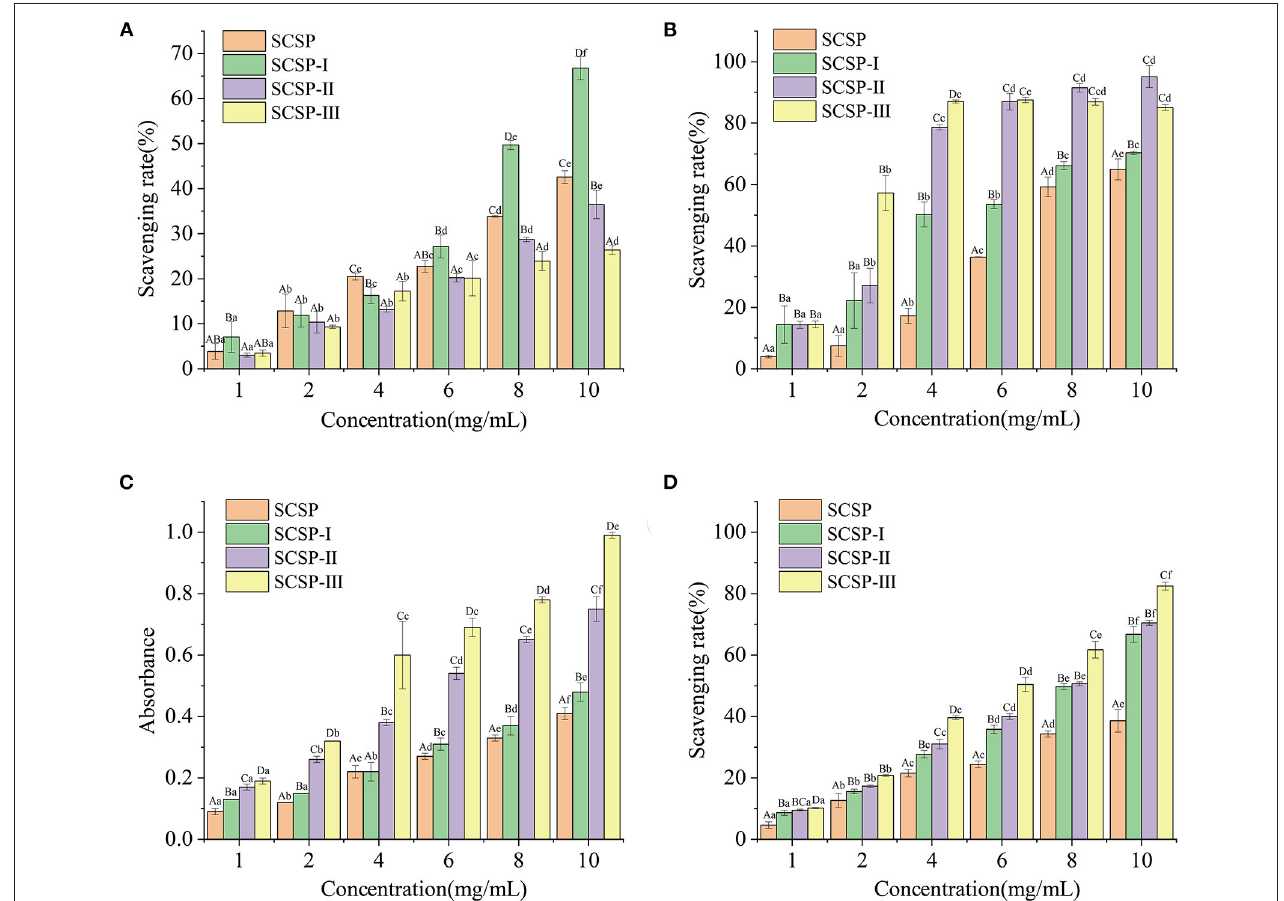
FIGURE 5 | MALDI-TOF-MS spectral profiles of SCSPs. (A) SCSP, (B) SCSP-I, (C) SCSP-II, (D) SCSP-III.